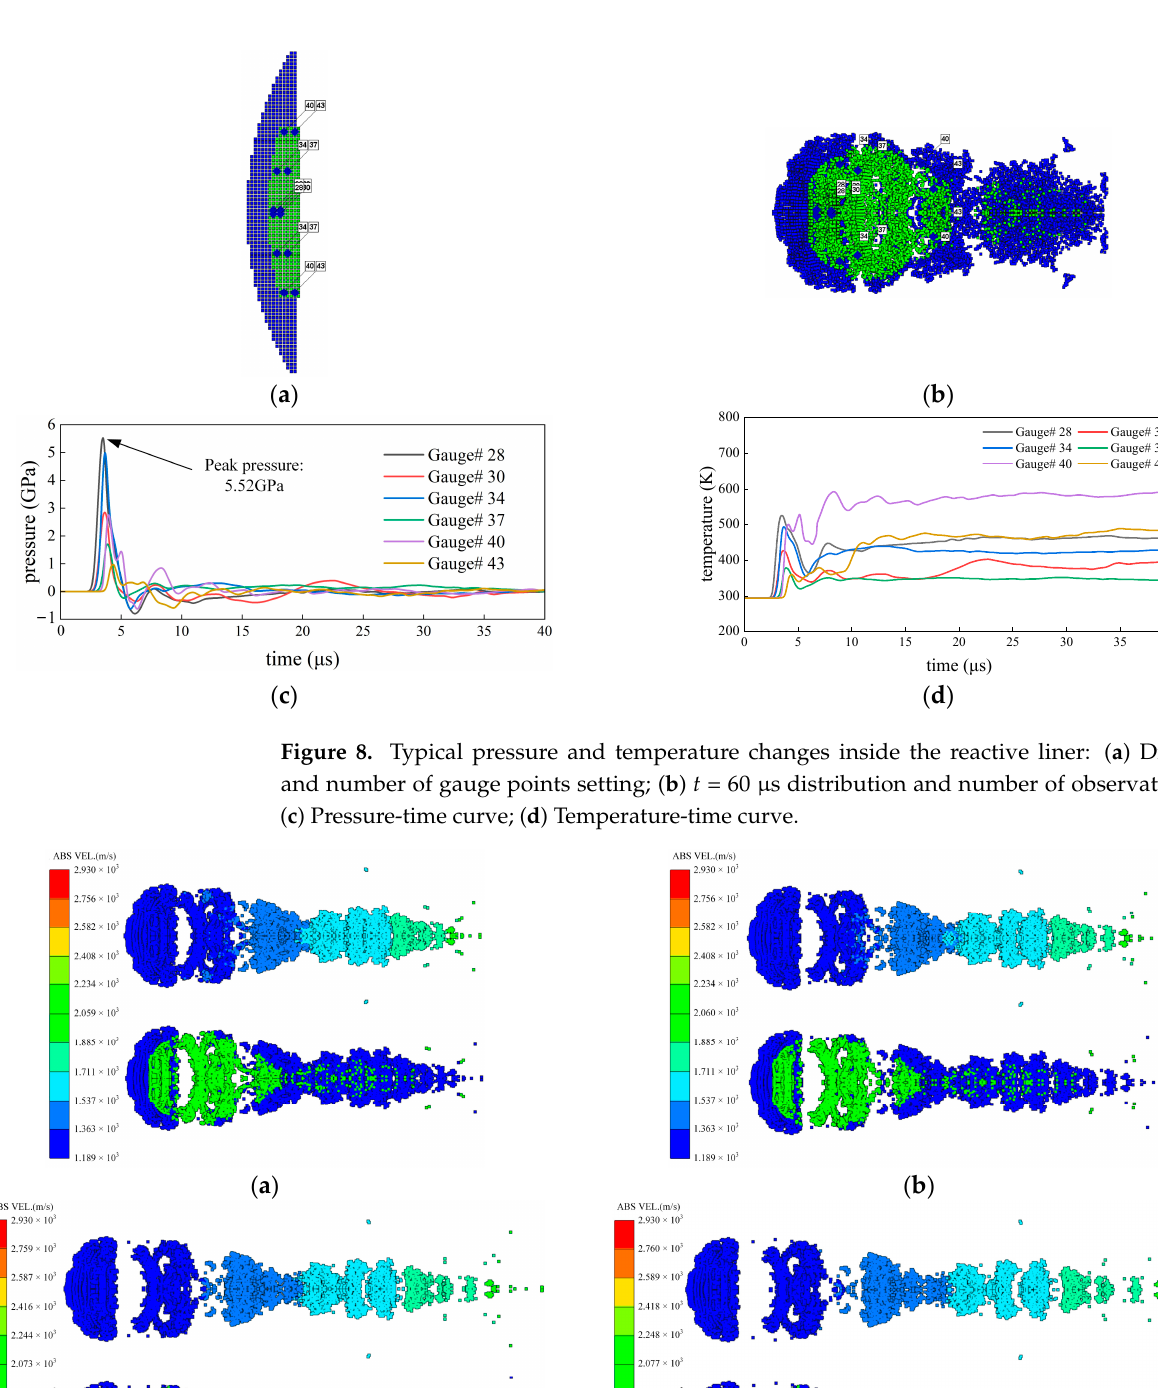
( e ) Figure 7. Closing phase: ( a ) t = 30 μ s; ( b ) t = 45 μ s; ( c ) t = 60 μ s; ( d ) t = 75 μ s; ( e ) t = 90 μ s. In order to study the internal pressure and temperature changes of the reactive liner during the impact phase and the closing phase, typical observation points are set at the outer and inner side of the reactive liner, as shown in Figure 8a,b, and the pressure curve of the corresponding point from 0 to 40 μ s was obtained as shown in Figure 8c; the tem ‐ perature curve from 0 to 40 μ s is shown in Figure 8d. It can be seen from the figure that the pressure inside the reactive liner during the formation process can reach 3 GPa, which mainly occurs when the copper liner strongly impacts the reactive liner, but the peak pres ‐